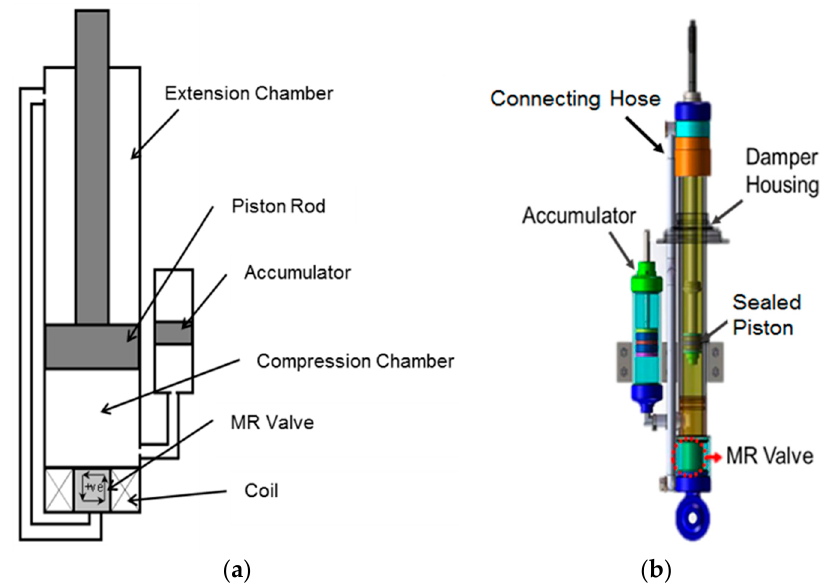
Figure 2. Schematic configuration of the proposed MR damper. ( a ) The conceptual design, ( b ) the actual design.